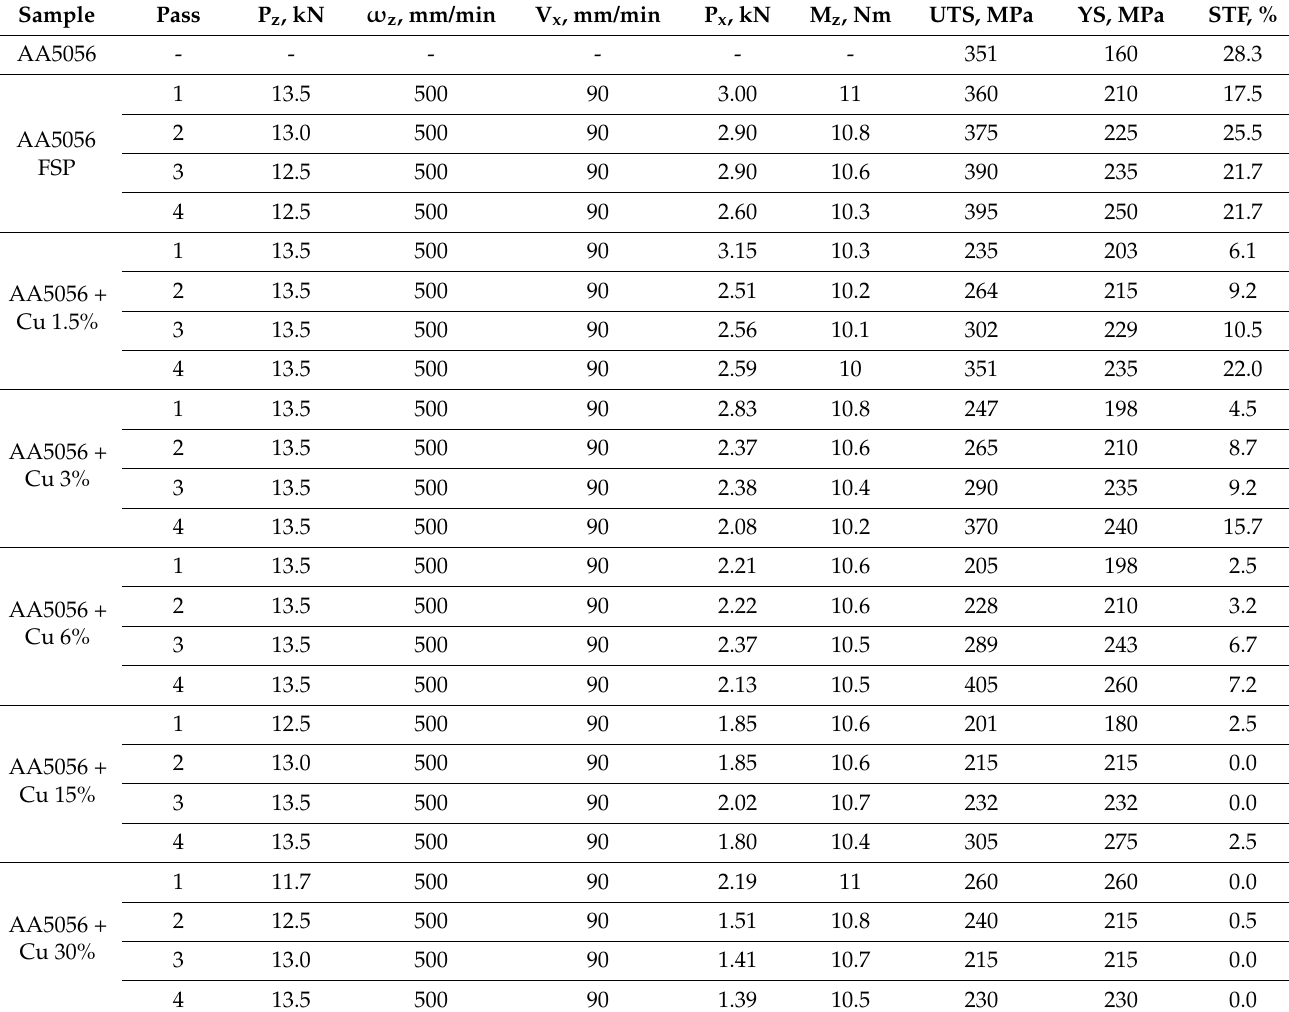
Table 1. FSP parameters and mean strength characteristics of composite